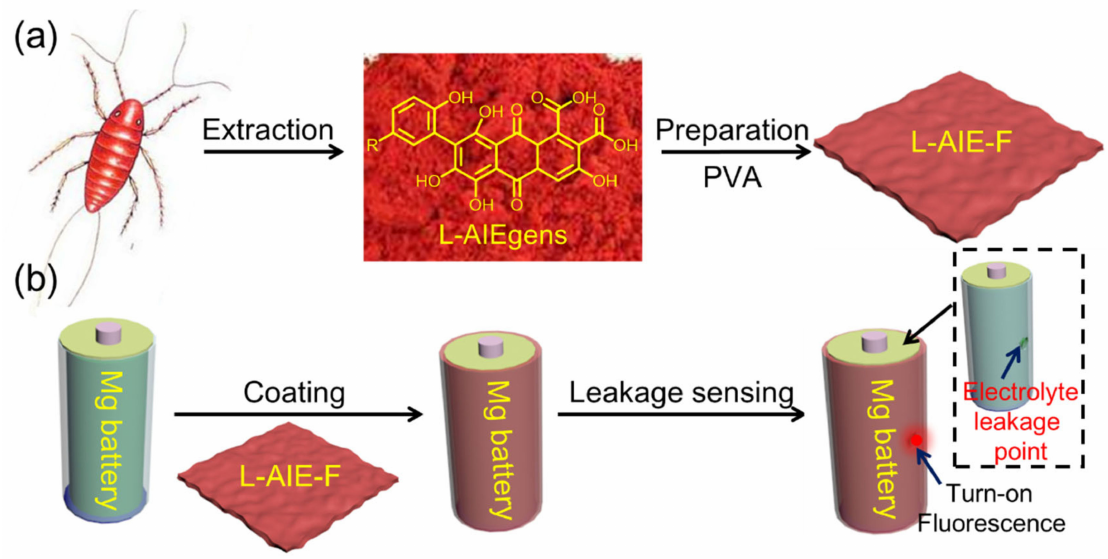
Figure 1. Schematic illustrations of the ( a ) preparation of L-AIE-F and ( b ) fluorescence sensing of electrolyte leakage from Mg